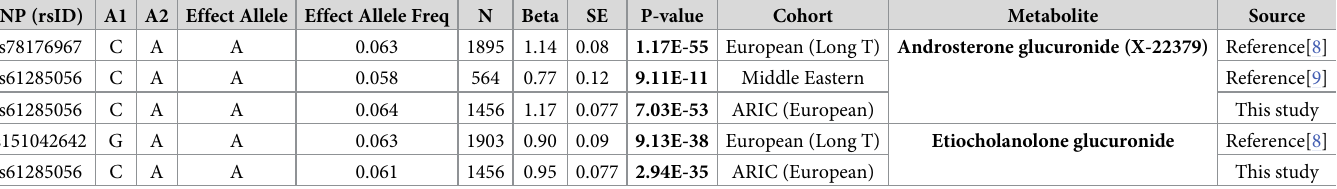
Table 2. Association of sentinel SNPs with two steroid conjugates in three cohorts. Association of sentinel SNPs with steroid glucuronide levels in two published stud- ies and in the ARIC cohort. According to 1000 Genome Project, European population, these SNPs (rs78176967, rs61285056 and rs151042642) are in strong LD with one another (D’ = 1, r 2 > 0.95). The A1 and A2 alleles are on the minus strand. The primary data are available through the established dbGaP application procedure for the ARIC study (dbGaP Study Accession: phs000280.v5.p1). SNP (rsID) A1 A2 Effect Allele Effect Allele